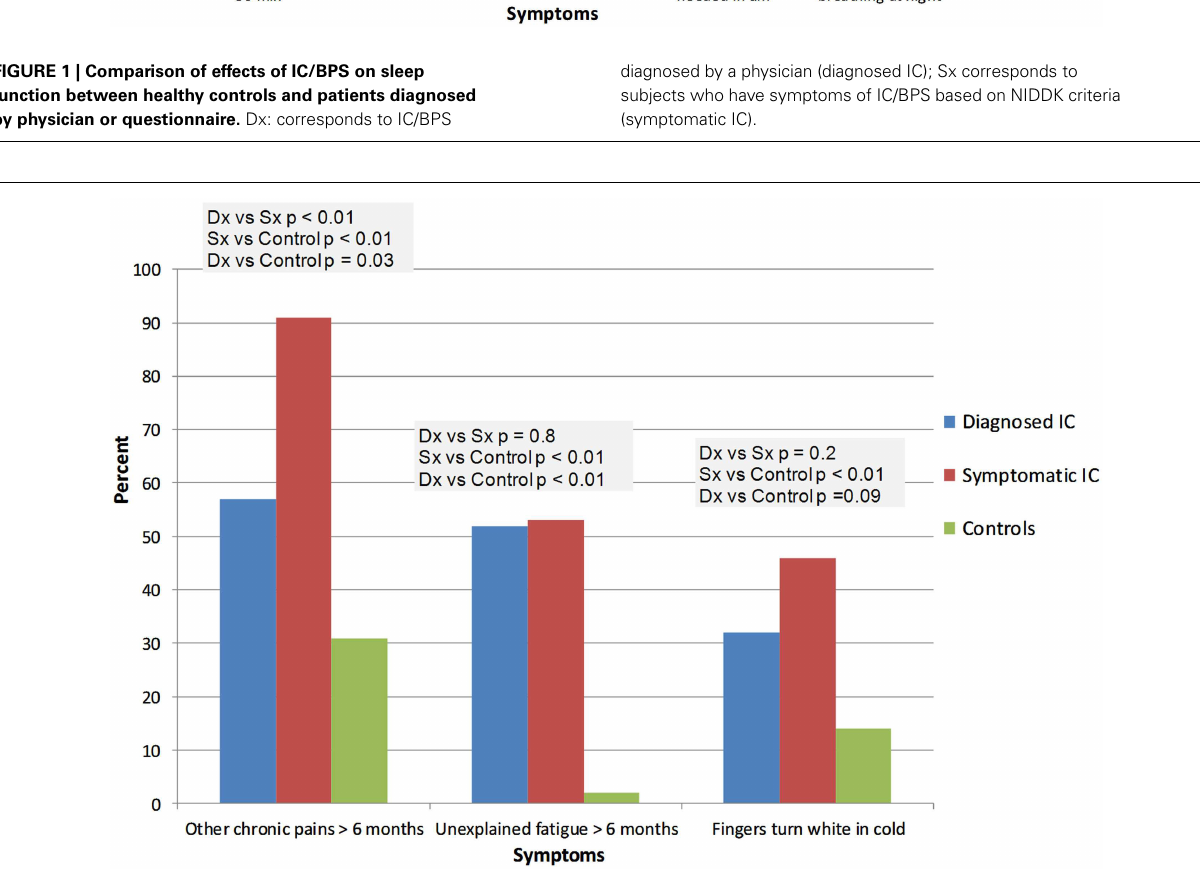
diagnosed by a physician (diagnosed IC); Sx corresponds to subjects who have symptoms of IC/BPS based on NIDDK criteria (symptomatic IC).